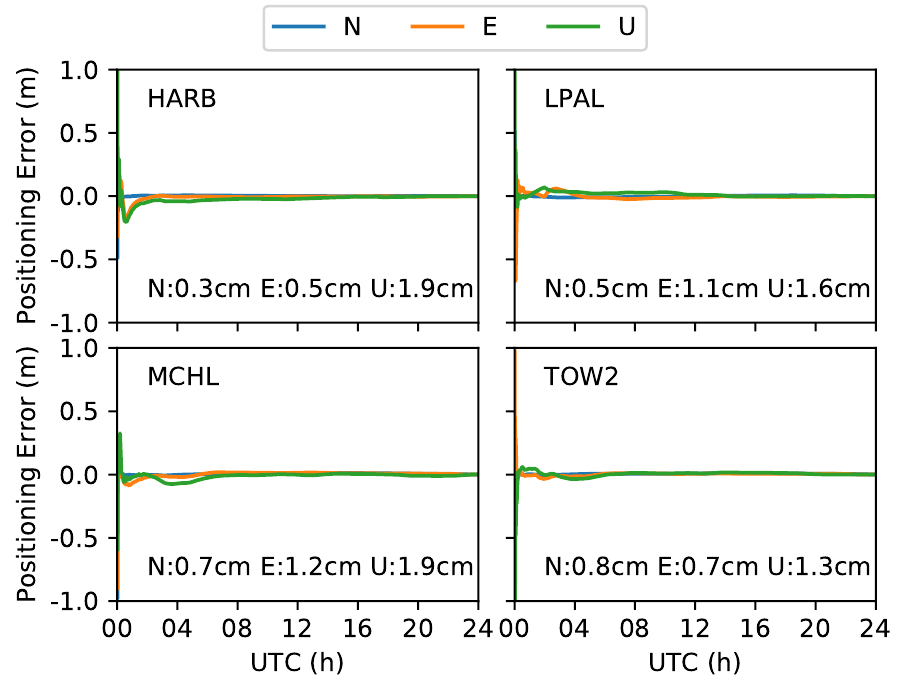
Figure 4. Positioning errors of 4 stations.